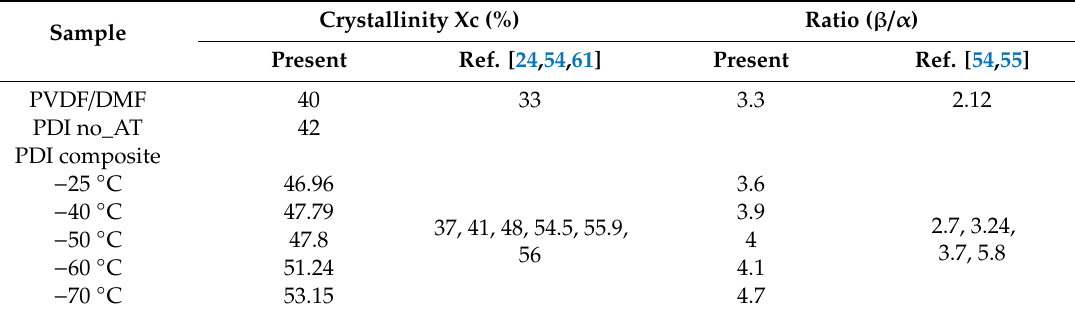
Table 3. Degree of crystallinity and ratio of β / α